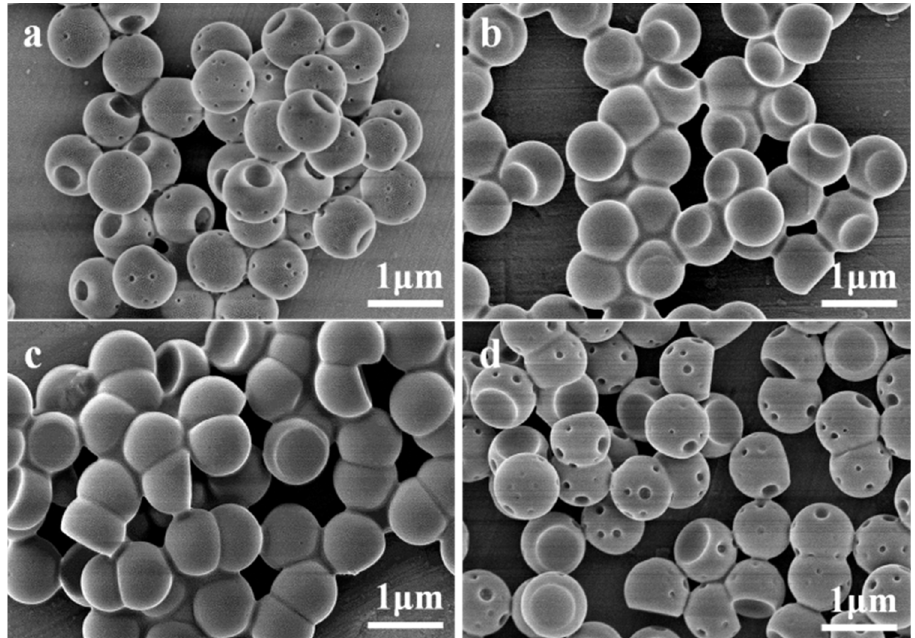
Figure 4. SEM images of PS/P(OFMA-S) composite particles prepared with a fixed w PX / w PS of 4 and different monomer ratios w OFMA / w St of ( a ) 1/4, ( b ) 1/2, ( c ) 2/1, ( d ) 4/1.